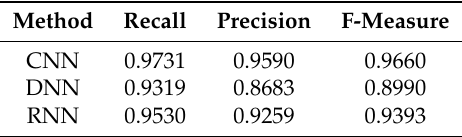
Table 1. Performance on onset detection using different neural networks. DNN: deep neural network; RNN: recurrent neural